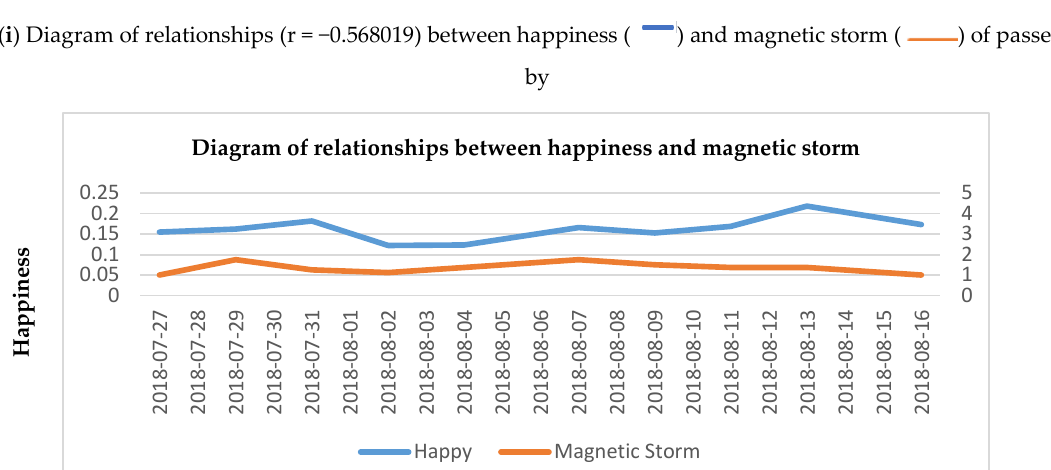
Diagram of relationships between happiness and magnetic storm